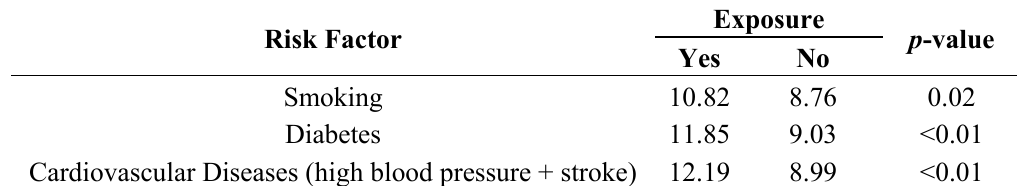
Table 1. Tooth loss average by risk factors (regression analyses adjusted by age, sex, and ethnic background) of 4,137 individuals from the University of Pittsburgh School of Dental Medicine Dental Registry and DNA